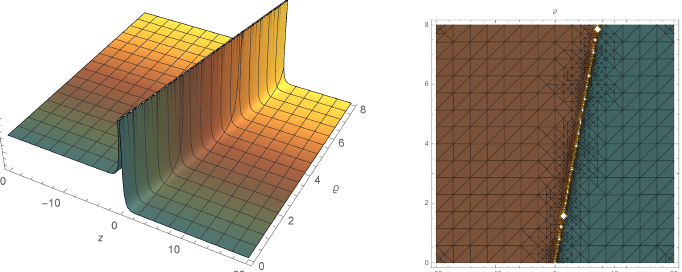
Figure 3. Three-dimensional (3D) and contour plots of the singular soliton solution of Equation (19).